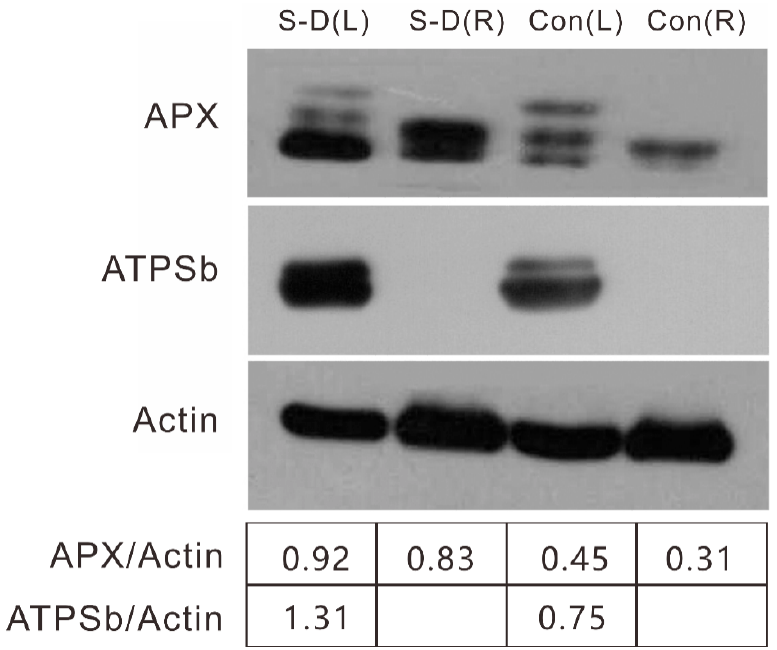
Figure 6. Comparison and validation of two candidate proteins by western blot analysis. Western blot analysis showed changes in APX (ascorbate peroxidase), ATPSb (ATP synthase subunit b), and actin as the internal control. Three replicates were conducted.